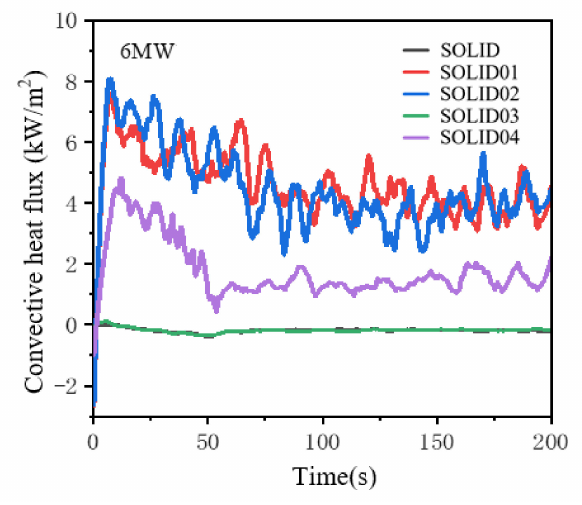
Figure 30. Convective heat flux of glass under window sprinkler